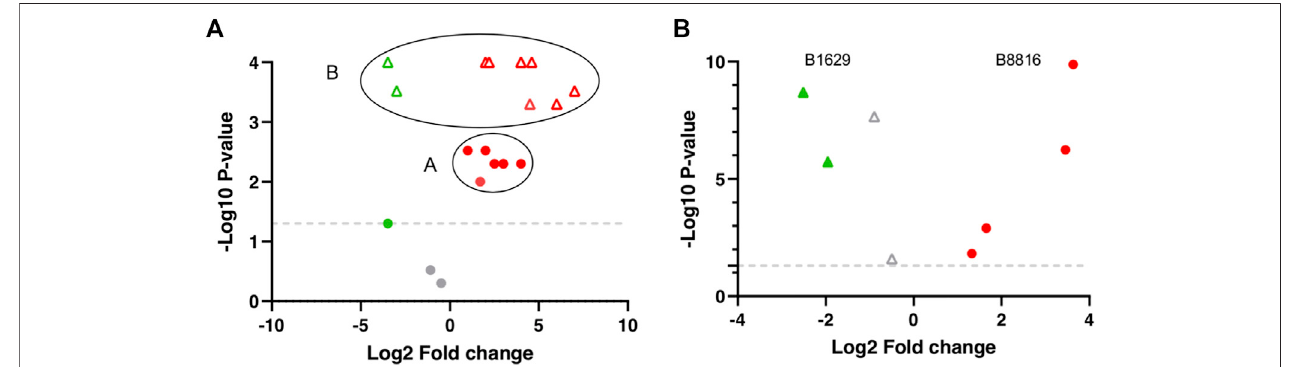
FIGURE 2 | Theoretical and Real centroiding clustering example visualized in a Volcano plot. (A) A and B represent 2 different molecules. Red and gray circles representmolecule Adistributionfromthedifferentdataset(DS)comparisons.Themajorityofmolecule Avaluesclusterregardingregulation,log2FC,and p -values(Red circles). Gray circles represent molecule A with non-signi fi cant p -values. Green and Red triangles represent molecule B distribution. All molecule B values are signi fi cant and cluster regarding regulation, log2FC, and p -values (Red triangles) but two DS comparisons (Green triangles). (B) B1629 and B8816 are real molecules within the DS matrix and represents an example of the distribution of 2 molecules from the biomarker list obtained through the FS